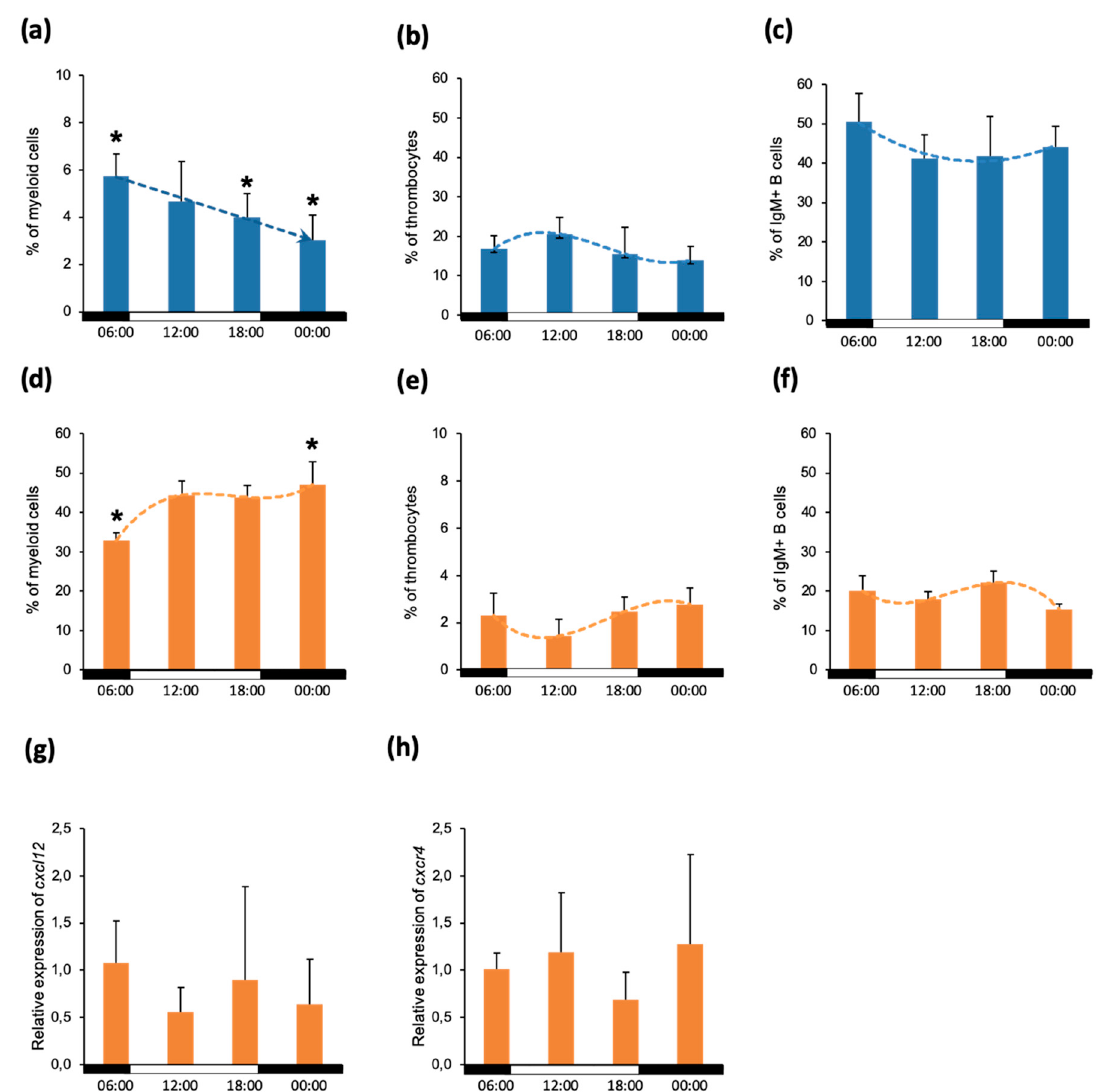
Figure 1. Composition of peripheral blood and head kidney leukocytes. Proportion of myeloid cells ( a ), thrombocytes ( b ) and IgM + B lymphocytes ( c ) in peripheral blood. The composition of head kidney is shown in the second row of the graphs: myeloid cells ( d ), thrombocytes ( e ) and IgM + B cells ( f ). Graphs ( g ) and ( h ) represent the relative expression of the genes cxcl12 and cxcr4 , respectively. The data is presented as mean values with standard deviation (SD) error bars. The statistical analysis used was one-way analysis of variance (ANOVA) and the Bonferroni post hoc test with p ≤ 0.05. Statistical di ff erences are represented by asterisks (*). The white and black bars on the x-axis demonstrate the dark / light period.